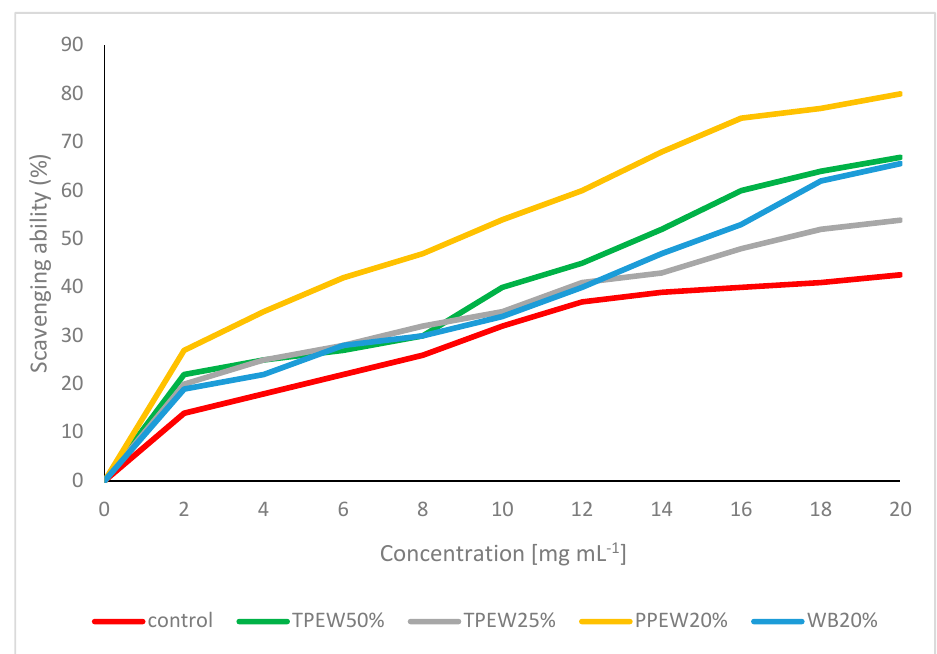
Figure 6. Scavenging ability on DPPH radicals of methanolic extract of Pleurotus citrinopileatus .